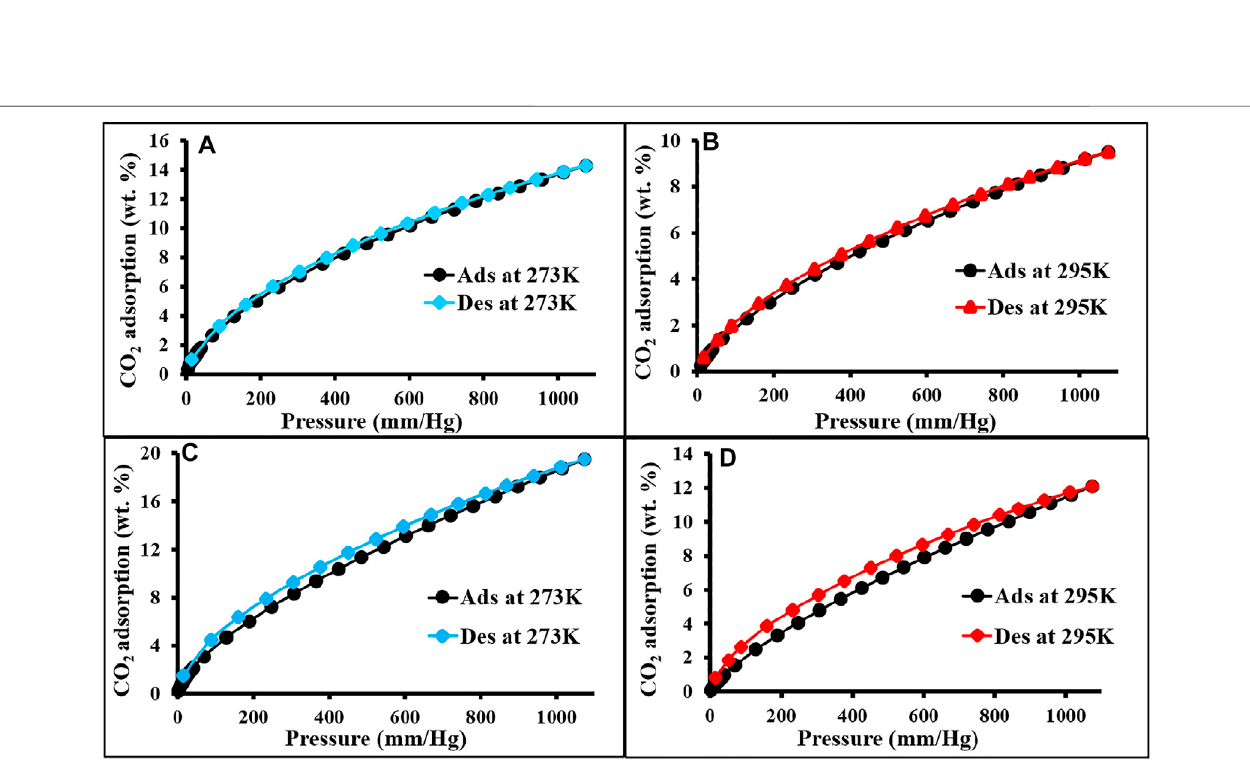
Frontiers in Chemistry |